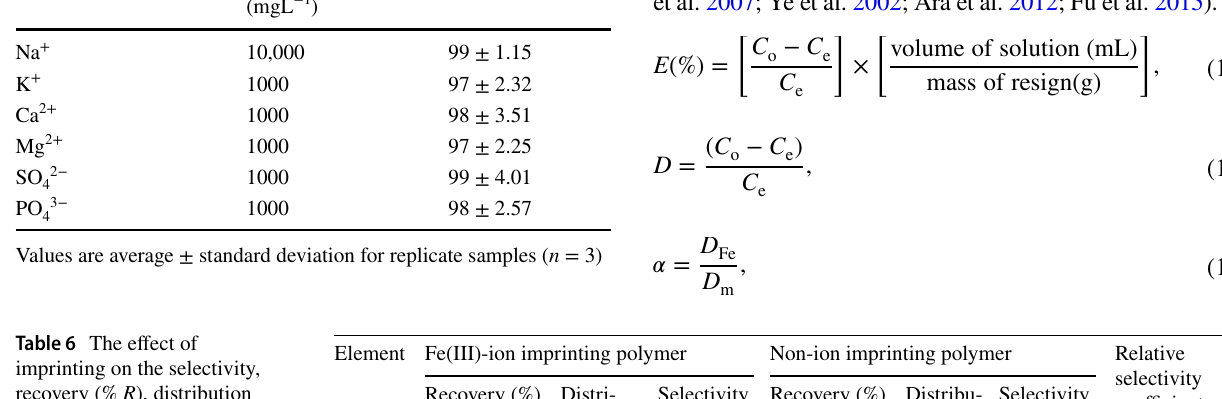
Element Fe(III)-ion imprinting